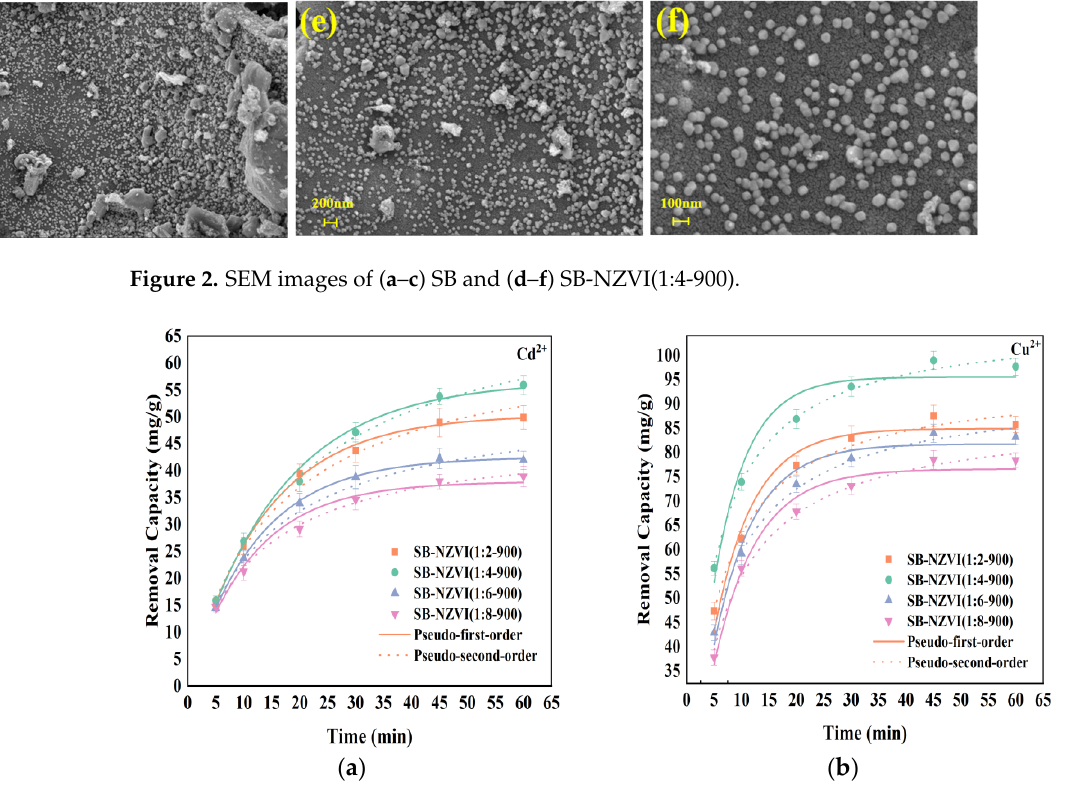
Figure 3. Adsorption kinetics models fitting for ( a ) Cd 2+ and ( b ) Cu 2+ removal by SB-NZVI composites at different mass ratios.